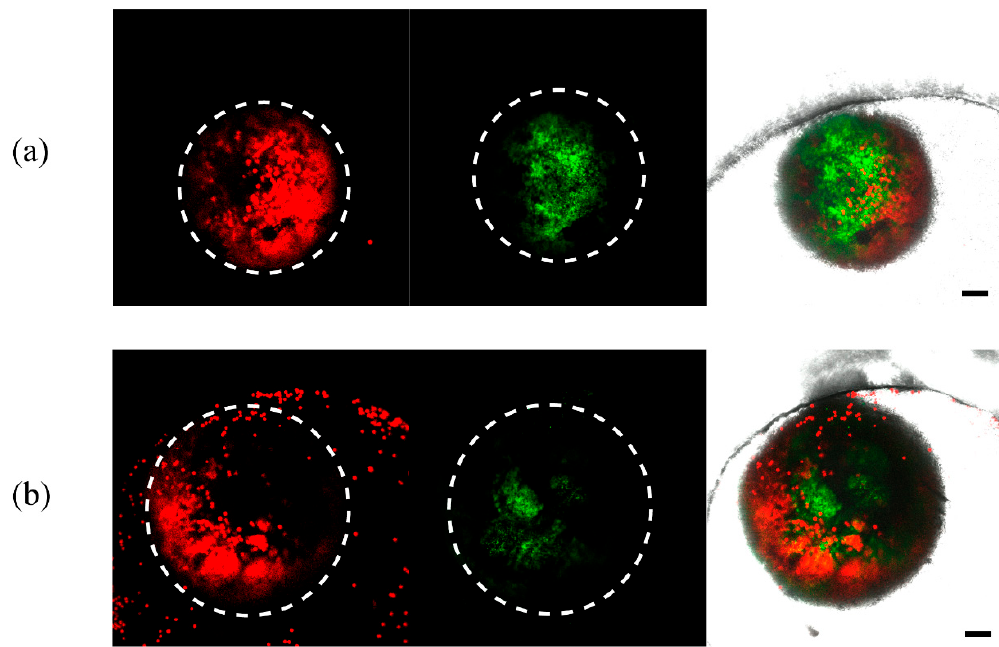
Figure 6. Impact of the temperature stress on the individual coral polyp. The morphologies of the coral polyps cultured at ( a ) 25 °C and ( b ) 31 °C in the microfluidic chip for 2 days. Left photographs are the autofluorescence images from the algal chlorophyll; middle photographs are the autofluorescences images from the native green fluorescent proteins; right photographs are the overlapped fluorescence images from both the algal chlorophyll and green fluorescent proteins (scale bar = 100 μ m).